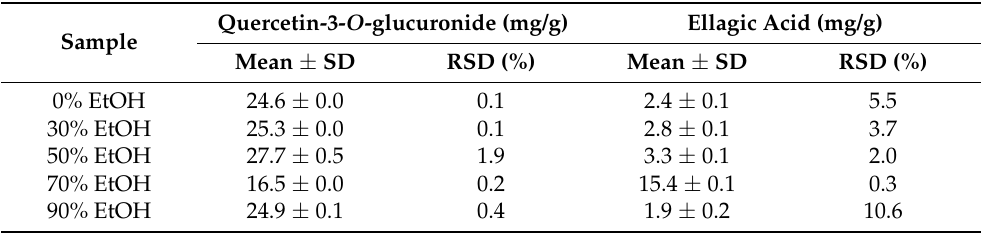
Table 4. Quantification of quercetin-3- O -glucuronide and ellagic acid in the evening primrose extract depending on extraction